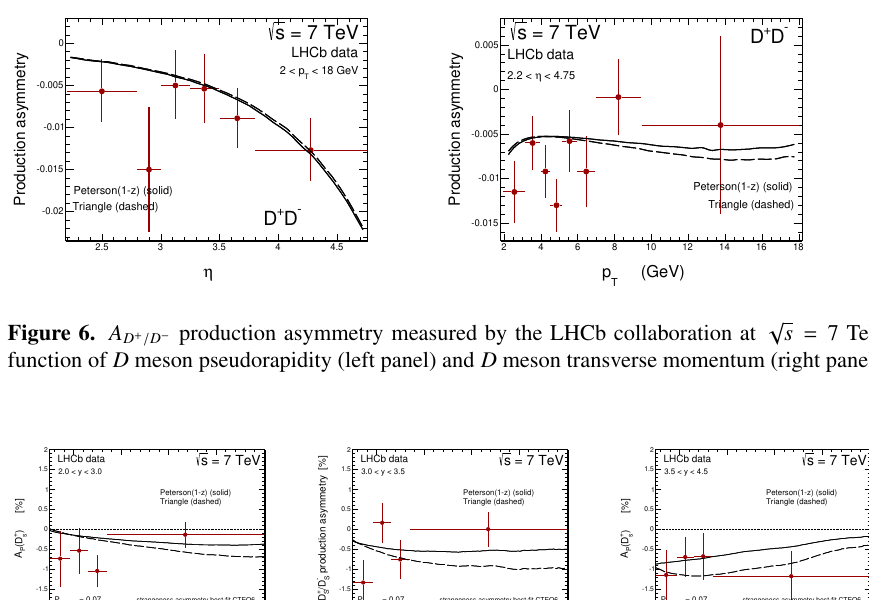
Figure 7. D + / D − asymmetry obtained by us together with the LHCb collaboration for s s The CTEQ6.5 parton distributions are used in this